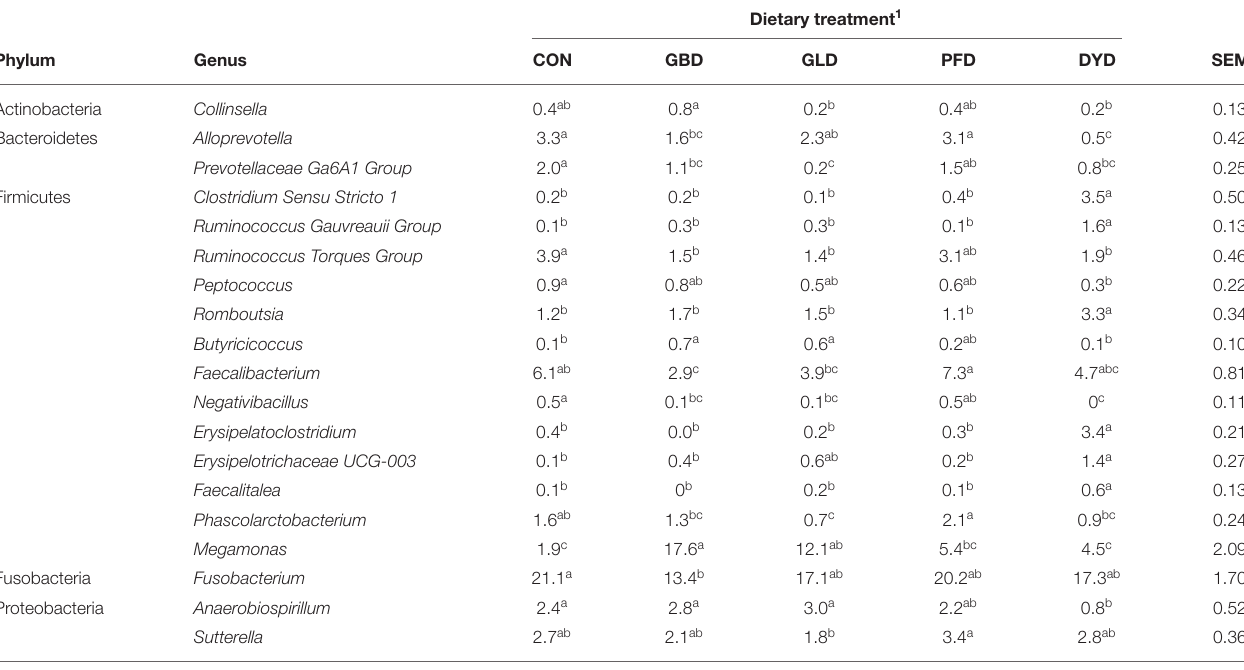
TABLE 9 | Relative abundance of bacterial genera of dogs fed diets containing legumes or yeast as the primary protein source.